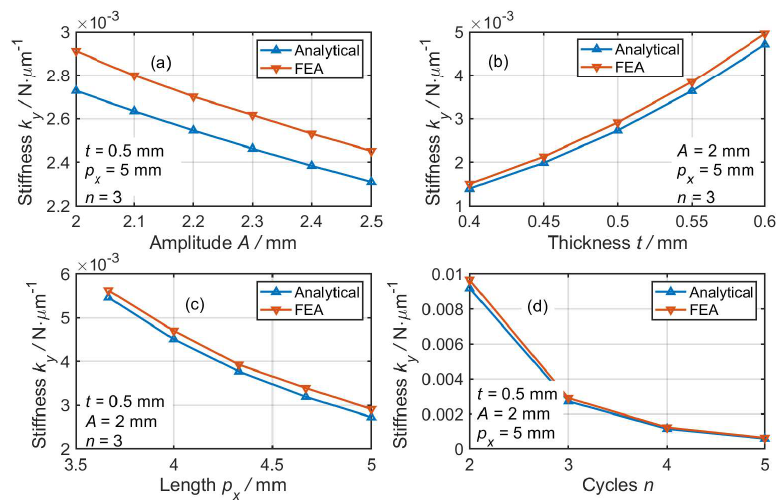
Figure 3. The y -axis stiffness k y of the sinusoidal corrugated flexure hinge related to ( a ) amplitude A , ( b ) thickness t , ( c ) length p x , and ( d ) cycle number n .